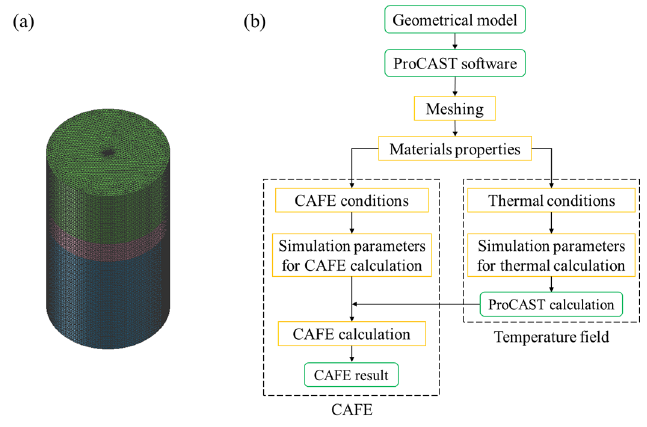
Figure 4. Meshes of heat transfer model of DC casting for high purity copper billet ( a ); and calculation flowchart used in the current work ( b ).